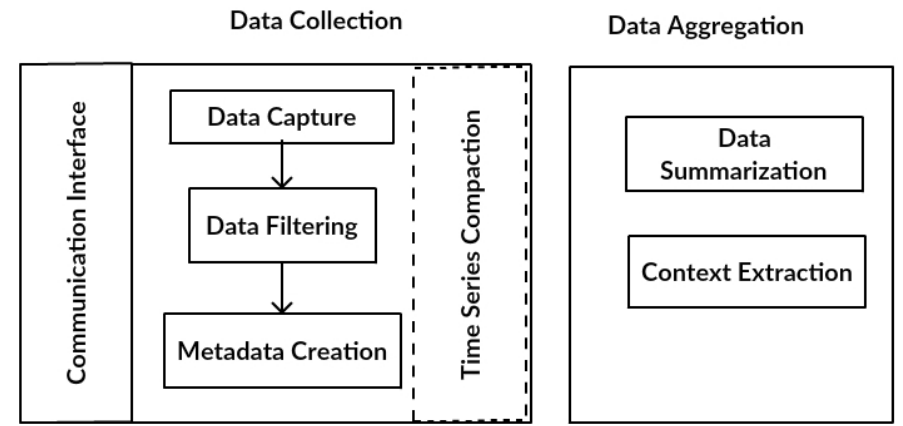
Figure 2. DDS components.